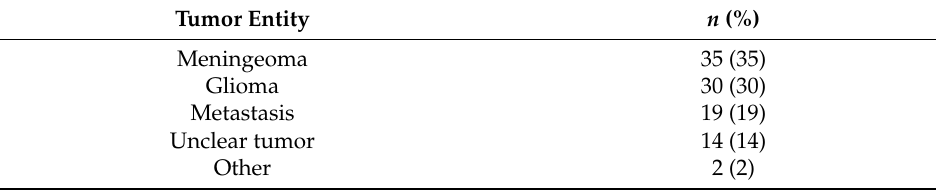
Table 2. Tumor entities among participants.